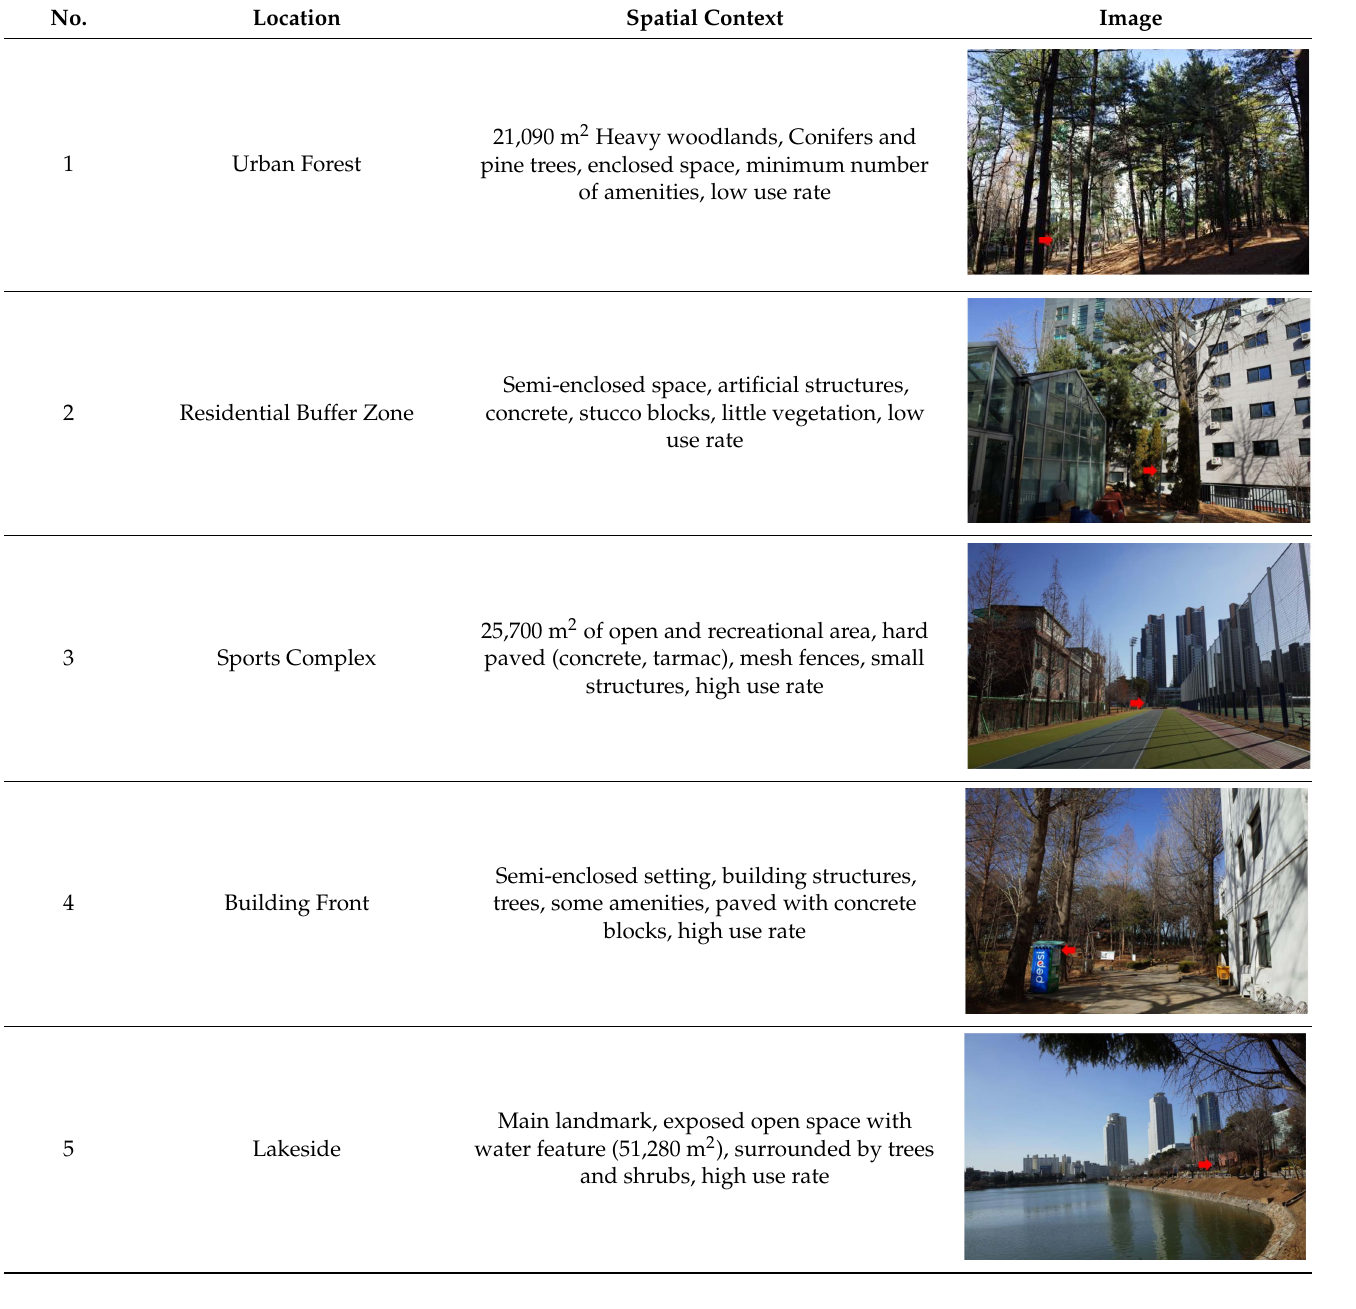
Table 1. Characteristics of PM measuring